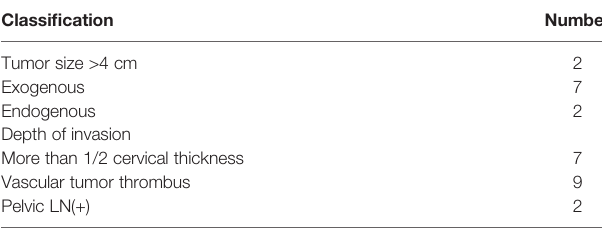
TABLE 3 | Tumor features